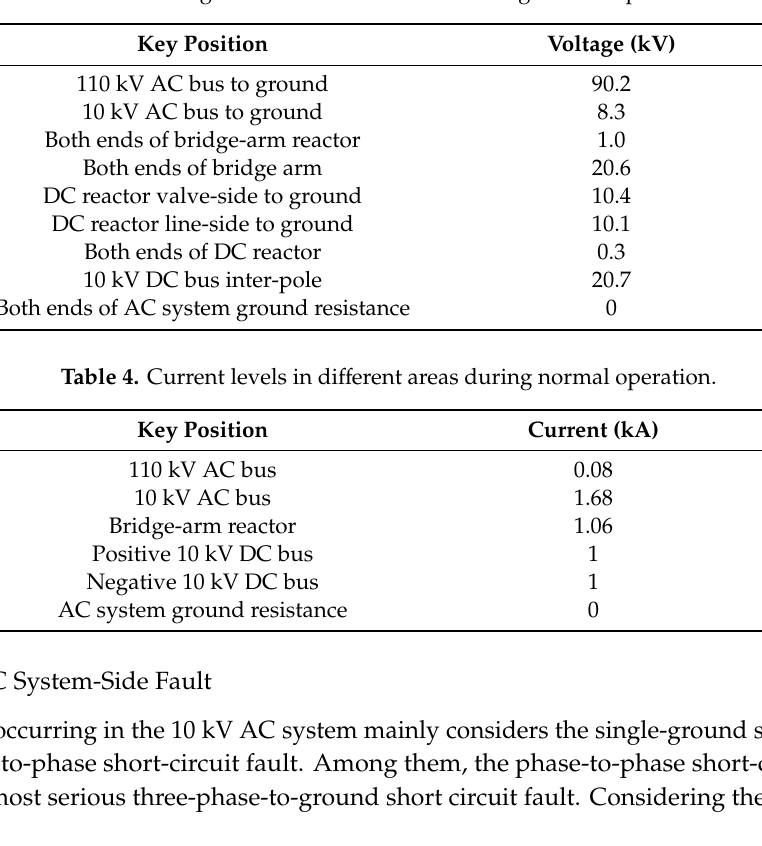
Table 3. Voltage levels in di ff erent areas during normal operation.